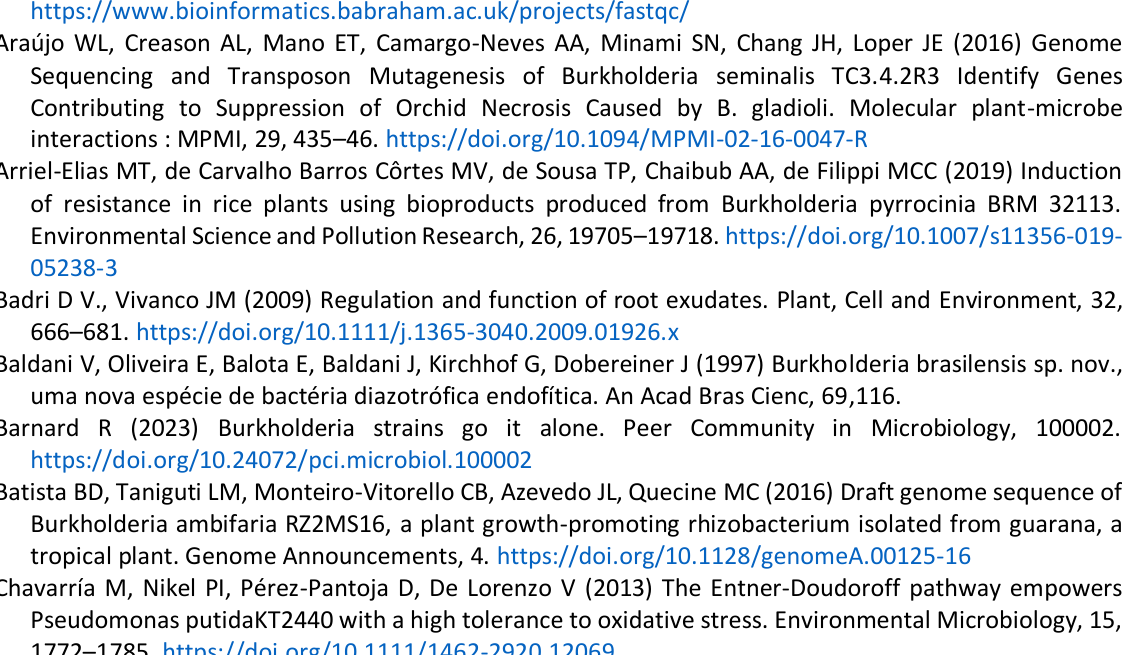
Table S1 – High throughput sequencing results of ribodepleted RNAs Table S2 – Culture media composition Table S3 – Listing of root exudate regulated genes across the six burkholderias Table S4 – List of custom probes used for rRNA depletion Figure S1 – Impact of bacterial inoculation on leaf (A) and root (B) dry weight, as well as leaf length (C) Figure S2 – Variance analysis between transcriptome